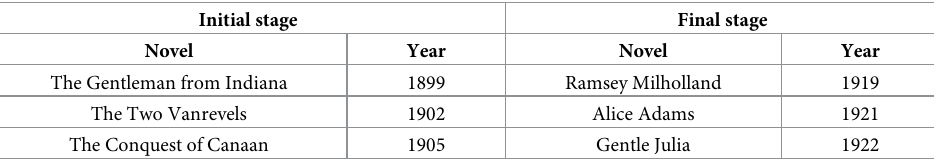
Table 5. Novels of author